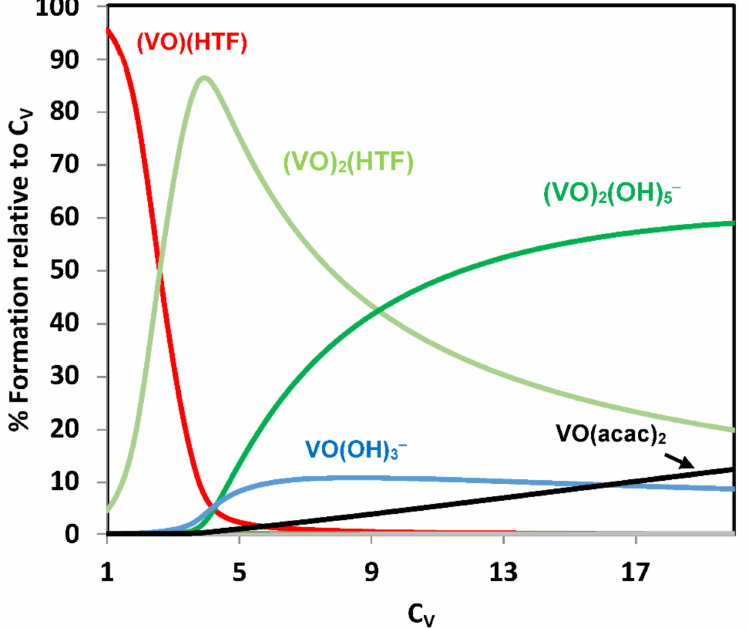
Figure 4. Species distribution diagram for the system V IV O 2+ + acetylacetone + apoHTF, for [apoHTF]= 2 × 10 − 6 M and [V IV O(acac) 2 ] in the range of 1 to 20 µ M, at pH = 7.4, considering the formation constants reported in [9,15,22,46], and the formation constant of ([V IV O(acac) 2 ]) 1 (apoHTF)] (=10 20.27 ) as obtained from fluorescence quenching methods. The calculations were carried out with the computer program HySS